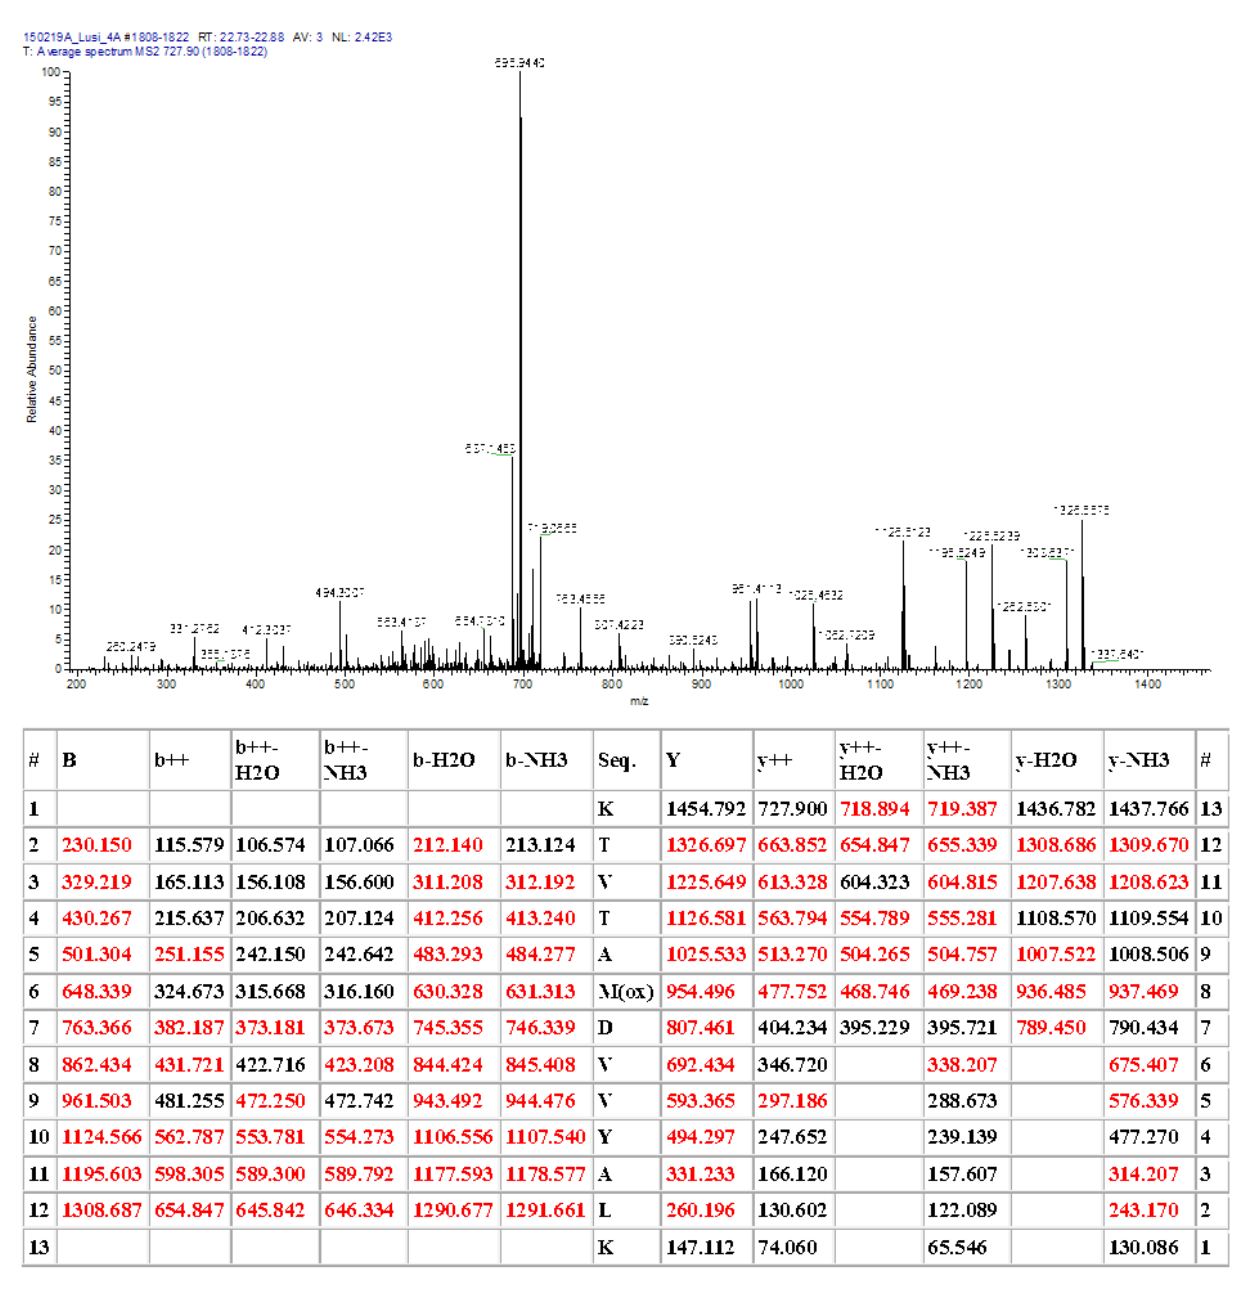
Figure 9. Mass spectrometry fragmentation pattern of the canonical human histone H4. Fragmentation table at t m/z= 734.907; z=2.